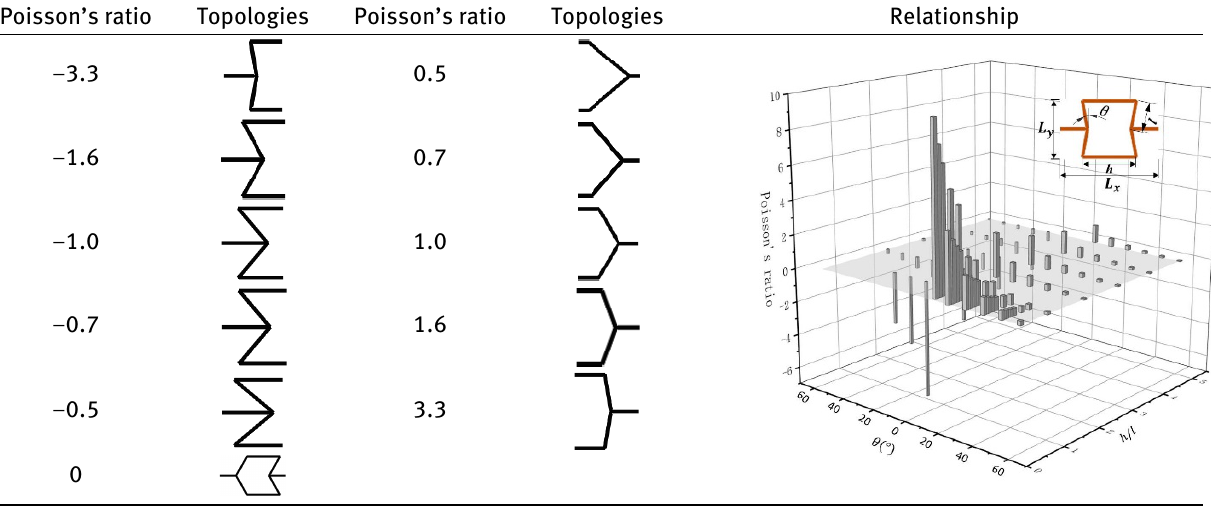
Table 1: Honeycombs with different Poisson’s ratio induced by topological diversity Poisson’s